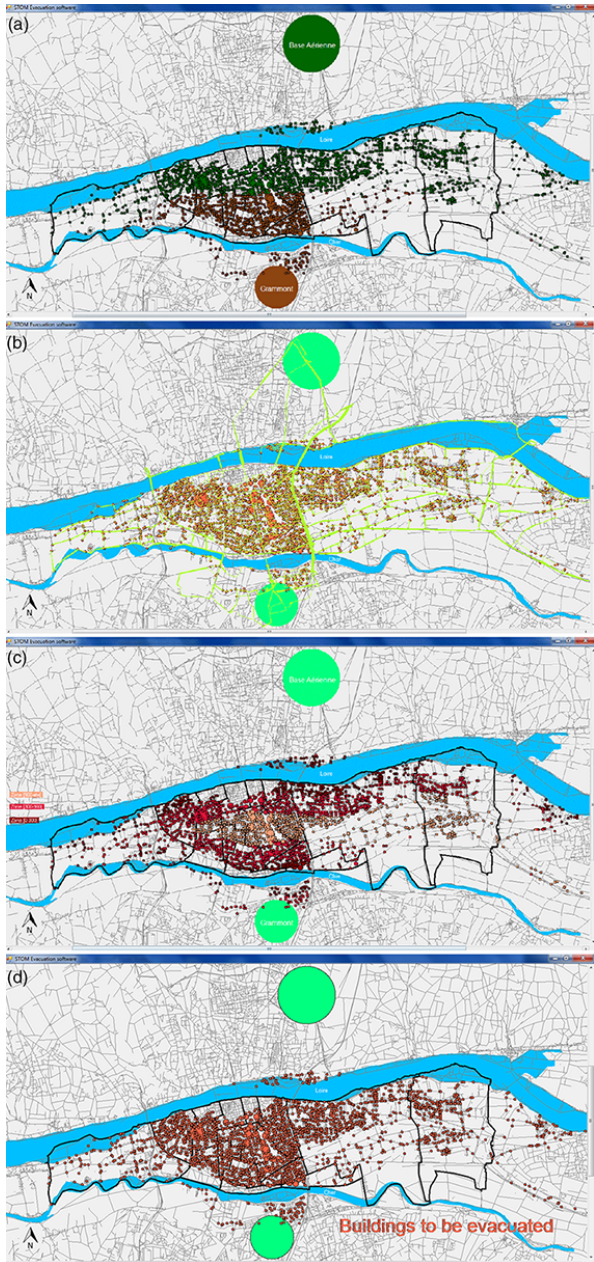
Figure 11. tain network roads even after 107 h from the beginning of the flood, allowing for a possible evacuation of some buildings not yet